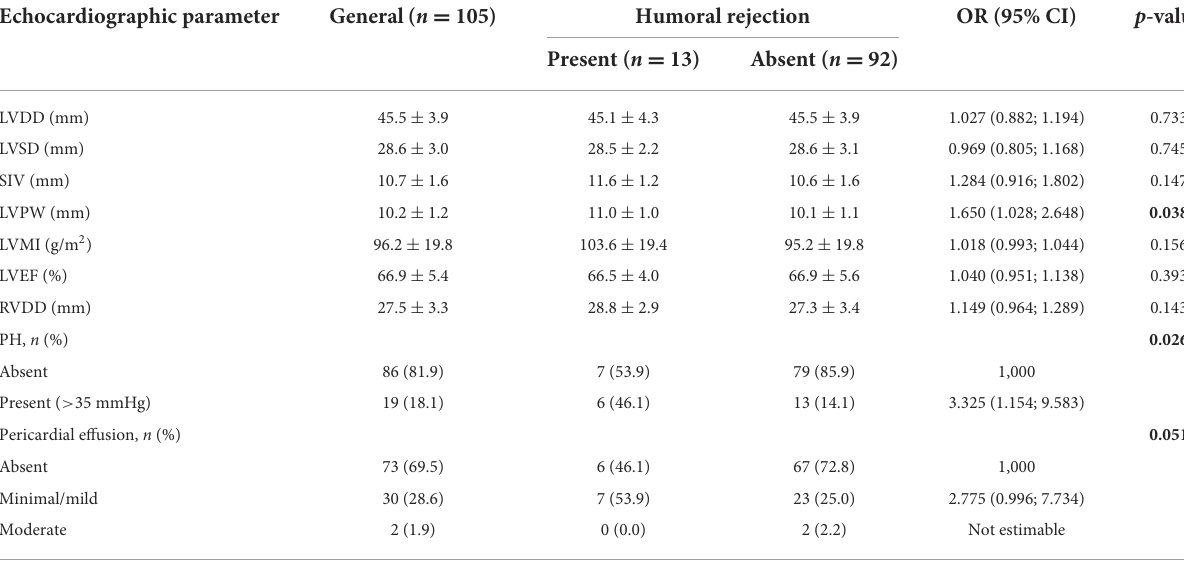
TABLE 12 Conventional echocardiographic parameters obtained by two-dimensional and descriptive evaluation according to antibody-mediated (humoral) rejection identified by immunofluorescence or immunohistochemistry. Echocardiographic parameter